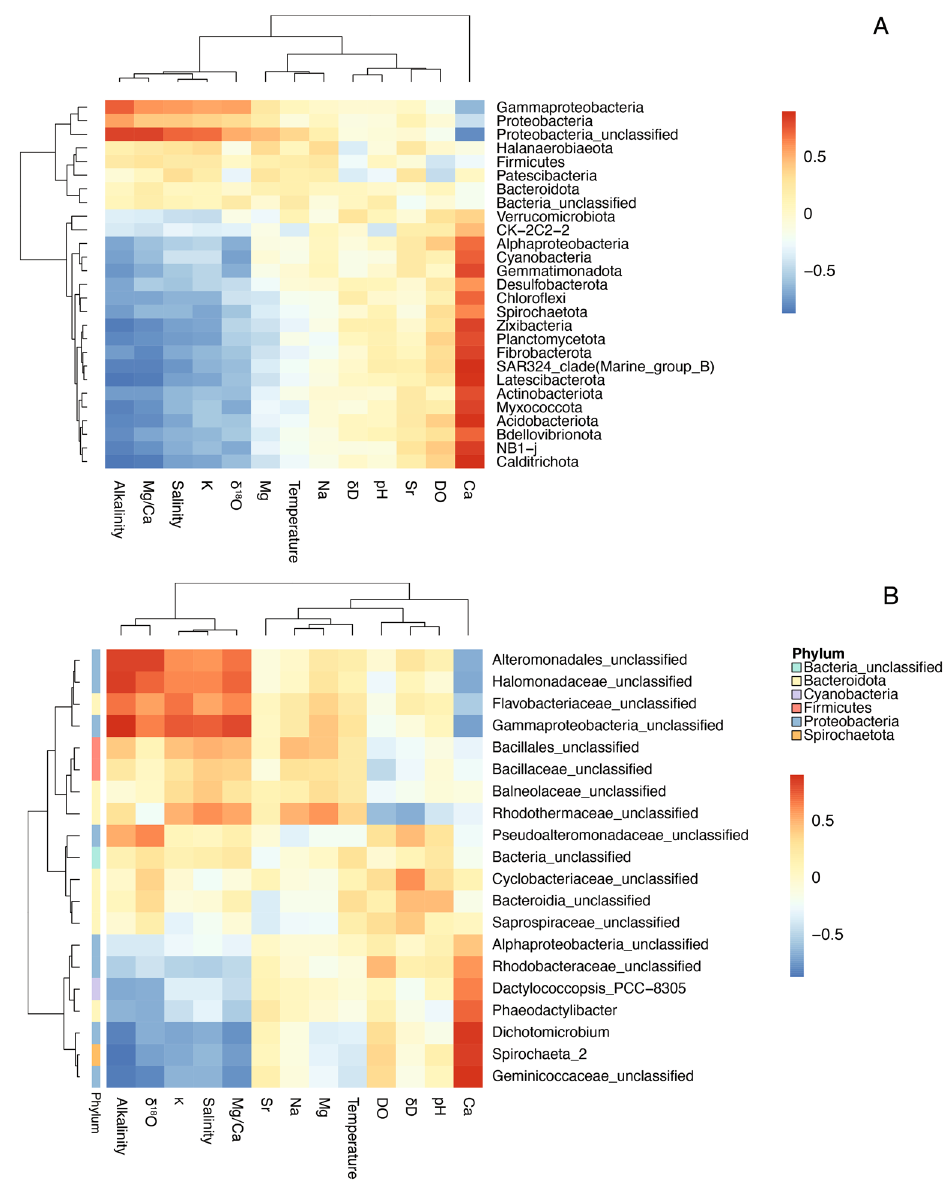
Figure 3. Heatmap of correlations between environmental factors and ( A ) bacterial phyla and ( B ) top 20 unique genus groups. Corresponding phylum of each genus group is also indicated in ( B ). For rows (microbial communities) and columns (environmental factors), dendrograms from hierarchical clustering using the distance and clustering methods distfun and hclustfun are made and shown in the figure. All analyses were performed using R Statistical Software (v4.1.3; R Core Team 2022, https:// www.R- proje ct.